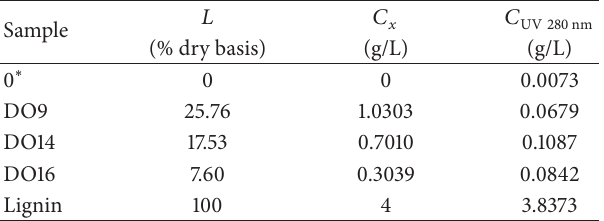
Table 8: Xerogels and lignin solubility in pH 12 solution.